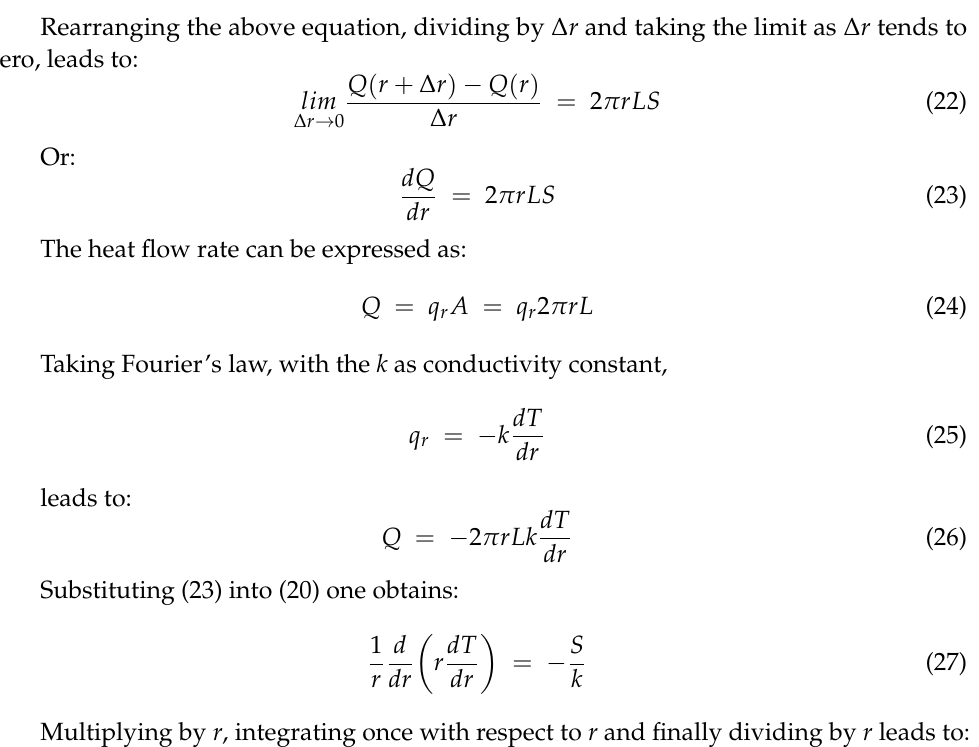
Figure 10. Distribution of